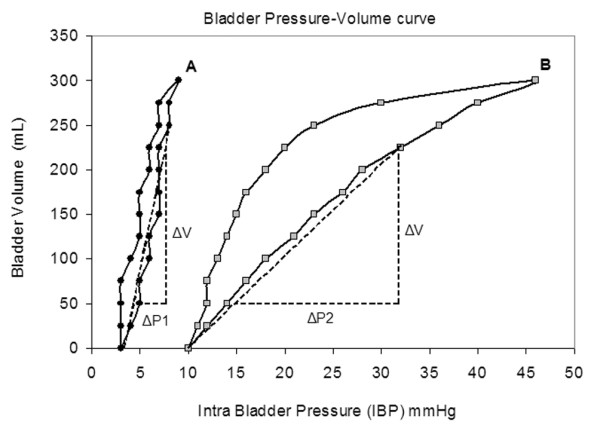
Example of two bladder pressure volume (PV) curves. Curve A (black circles) shows the bladder PV curve in a patient with a normal bladder compliance: baseline intra-bladder pressure (IBP; at empty bladder) was 3 mmHg; bladder compliance was 38.3 ml/cm H2O (ΔV/ΔP1). Curve B (grey squares) shows the bladder PV curve in another patient with a low bladder compliance: baseline IBP (at empty bladder) was 10 mmHg; bladder compliance was 10.2 ml/cm H2O (ΔV/ΔP2). The PV curves are shown with the inflation/filling limb (right hand side) and the deflation/emptying limb (left hand side).